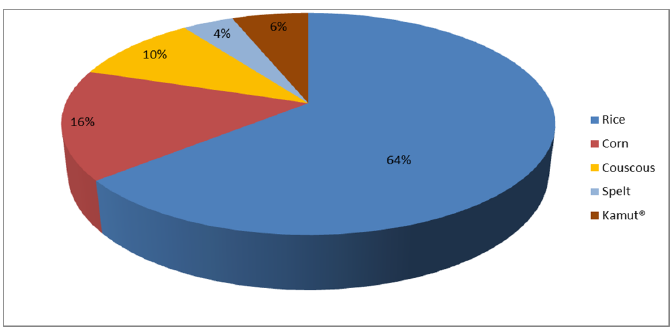
Figure 4. Raw cereal consumption of the control group.